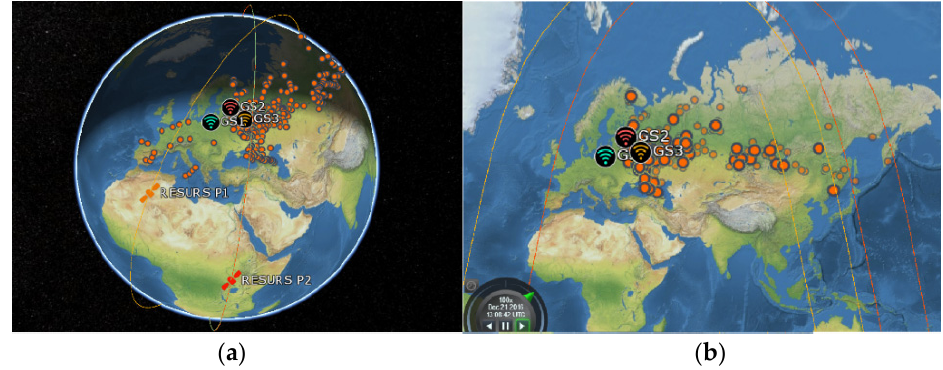
Figure 9. The number of orders for distant observation of Earth: ( a ) Geographical distribution of 3 satellites and 7 ground stations; ( b ) the initial set of orders for distant observation of Earth.